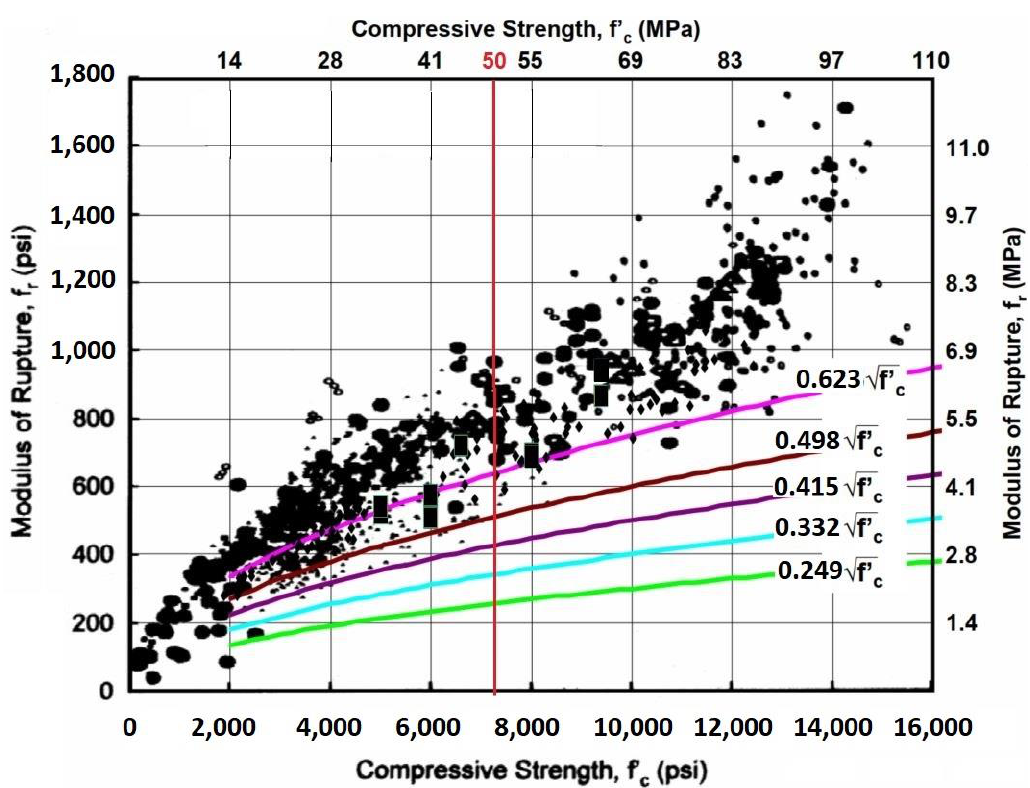
Figure 1. Relationship between Modulus of Rupture and Compressive Strength of Concrete (Data from 1330 tests).